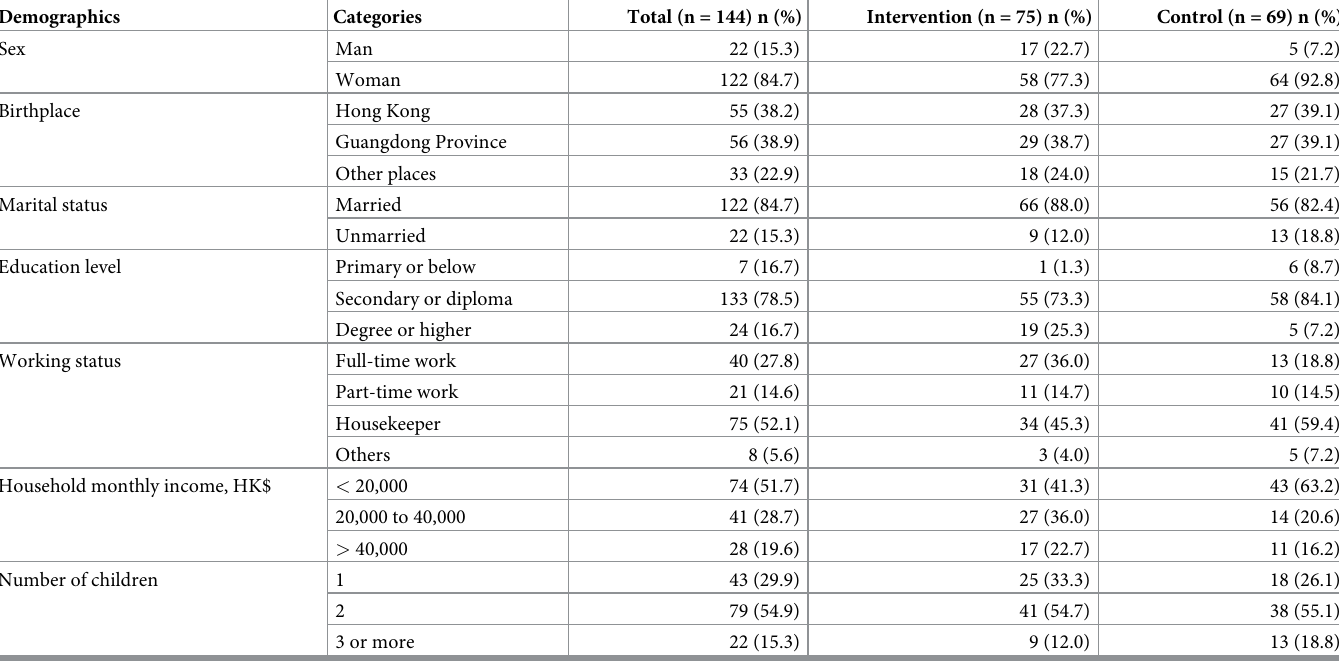
Table 1. Demographic